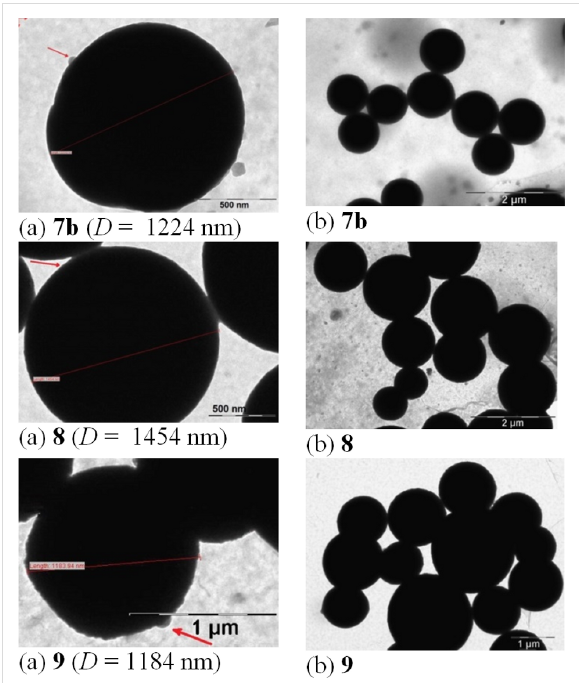
Figure 10: TEM images of homogeneously packed spherical nano- aggregates (a) and their agglomerations (b) in the case of G-2 ionic dendrimers 7b , 8 and 9 ; the red arrow indicates the nano-particles that aggregate. D is the average diameter of nanospheres.